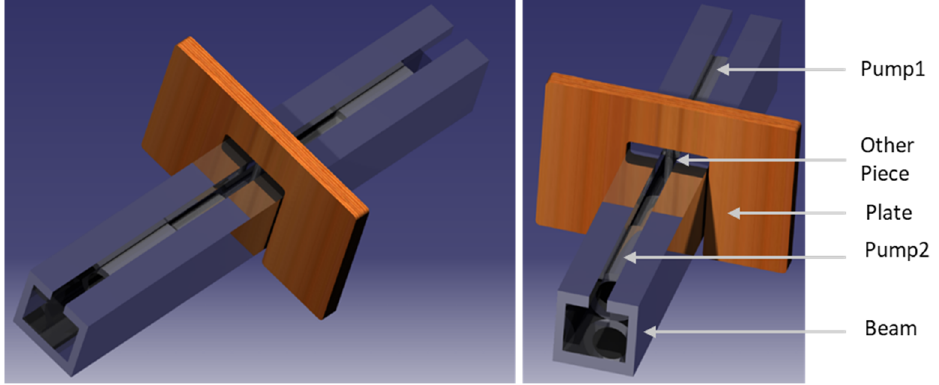
Figure 3. Collector artistic representation.